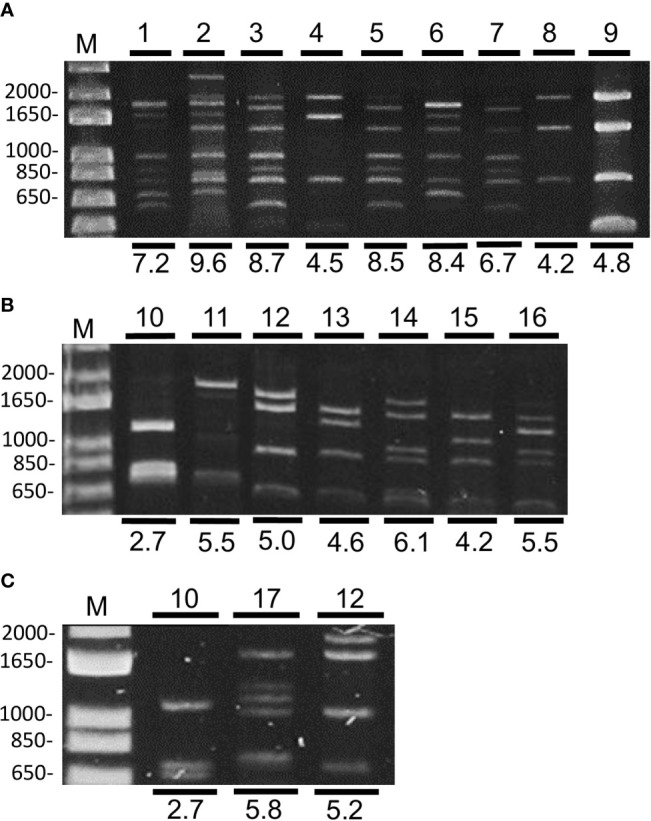
Restriction enzyme digestion profiles of begomoviruses amplified by RCA and digested with MspI on 1% agarose gel, observed in representative samples of G1 (A), G2 (B), and G3 (C). The estimated sum of each genome fragment (in kbp) is indicated below the restriction profile. M = 1 kb plus DNA ladder (Thermo Fisher Scientific).